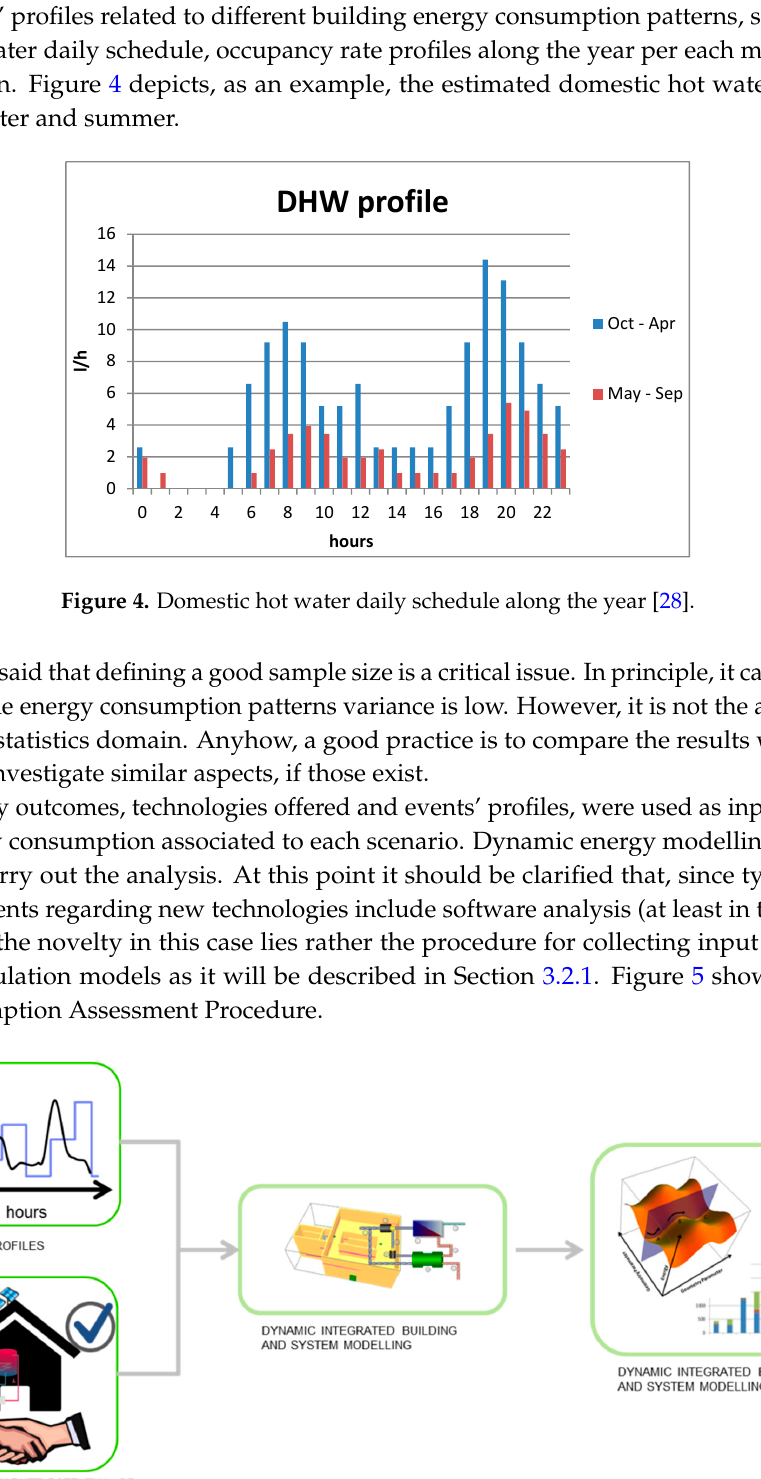
Figure 5. Building energy consumption assessment procedure [28].